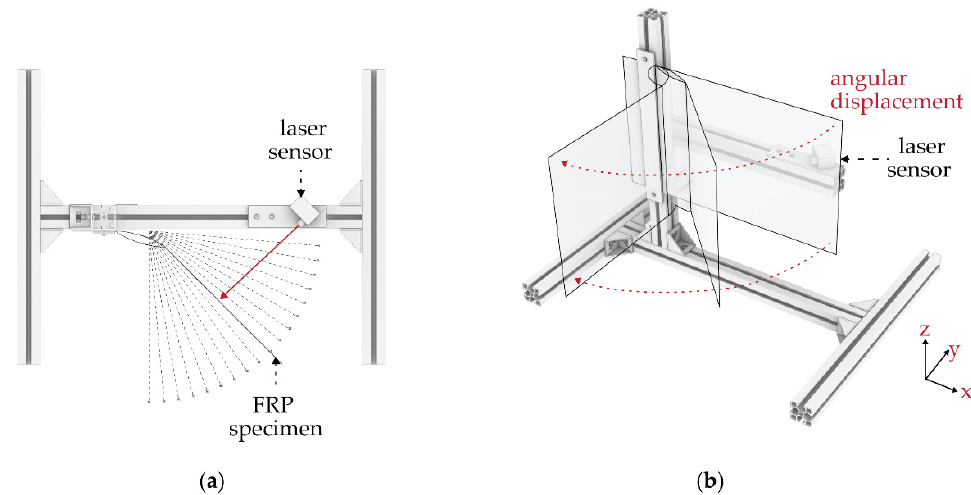
Figure 7. Vertical test set-up, with specimen clamped on one side to allow for the angular displacement ( a ) top view and ( b ) axonometric.